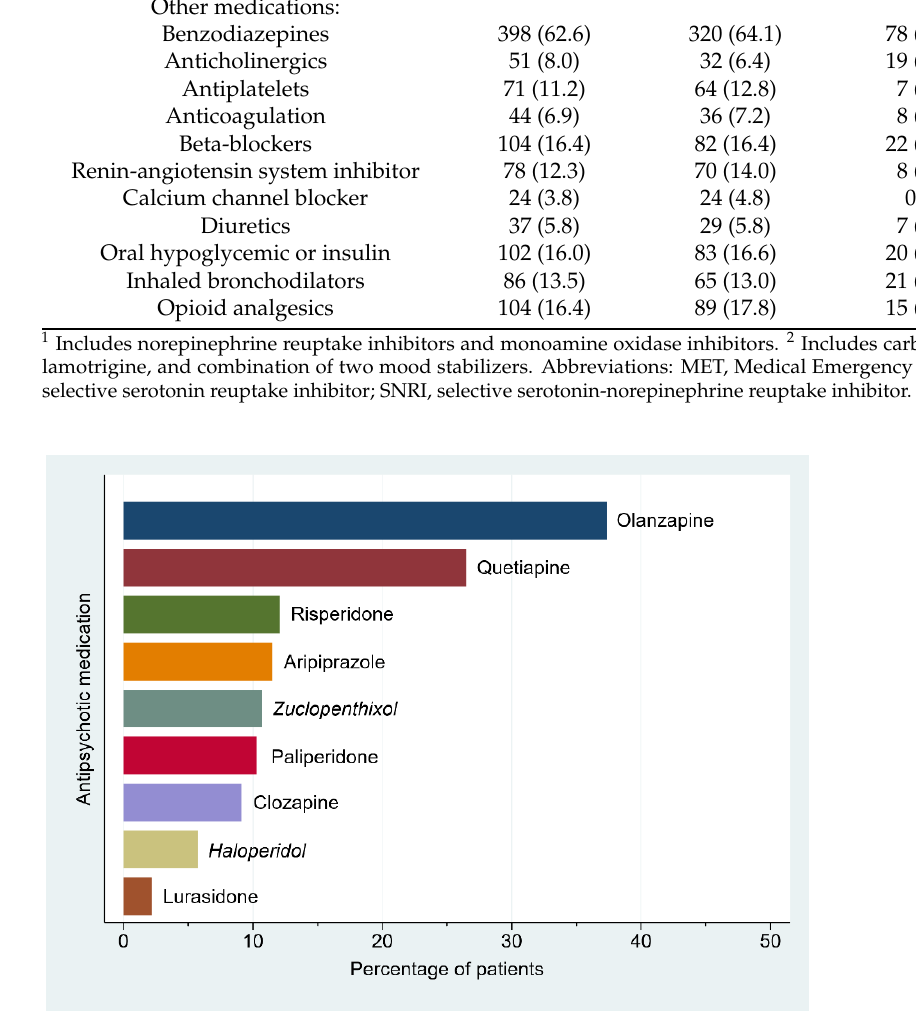
Table 2. Psychotropic and other medications used at the time of the Medical Emergency Team call.